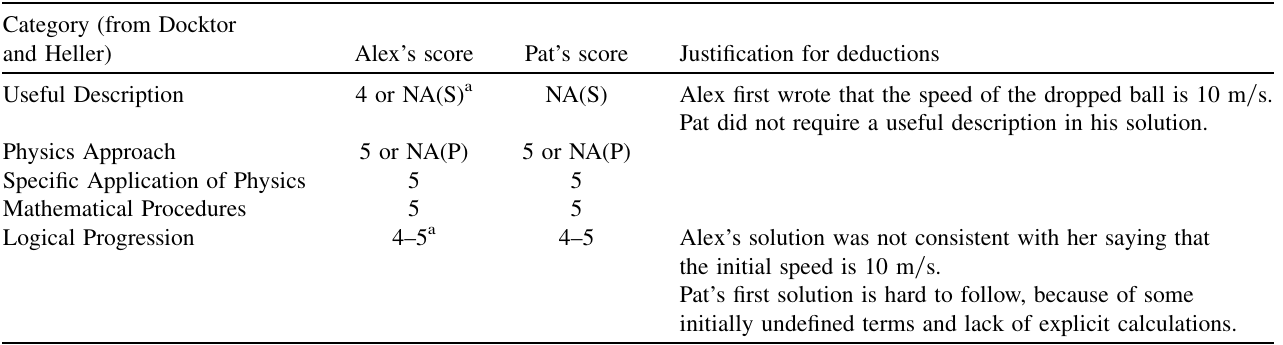
TABLE I. Pat and Alex score similar on the Doctor and Heller [3] rubric. Summary of scores on rubric categories. Category (from